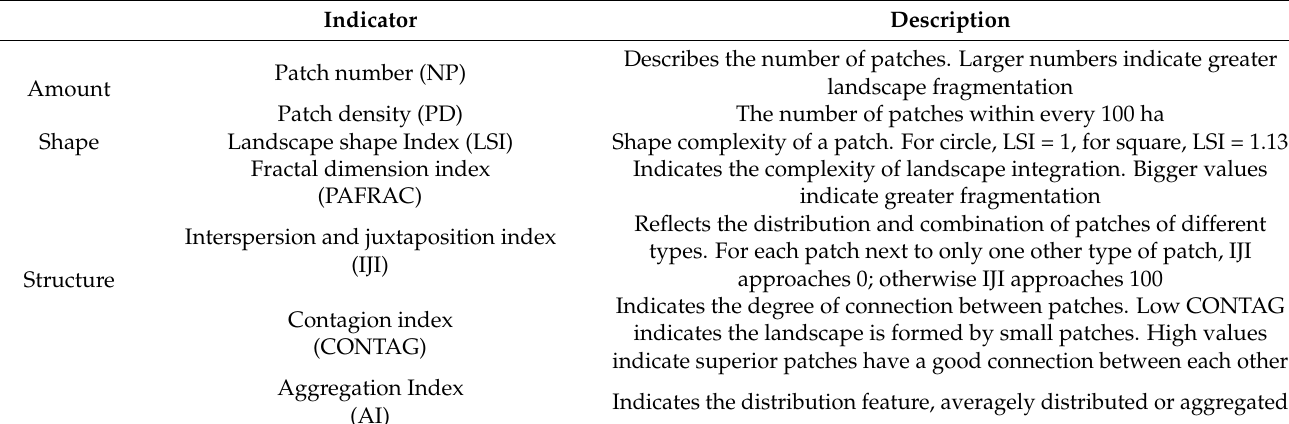
Table 2. Table 2. Selected indicators of landscape